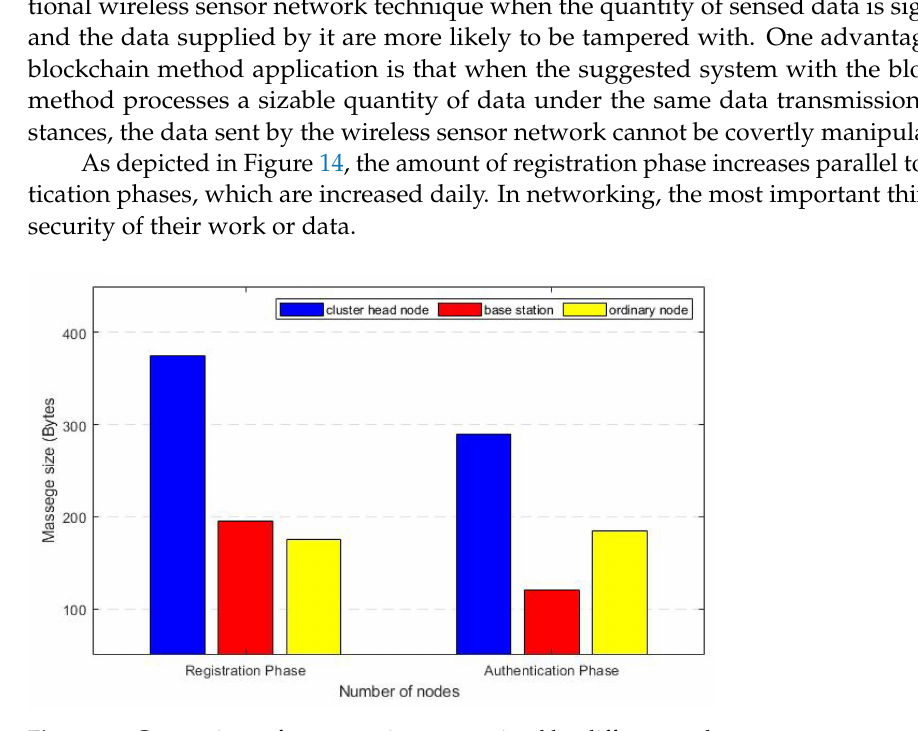
Figure 14. Comparison of message sizes transmitted by different